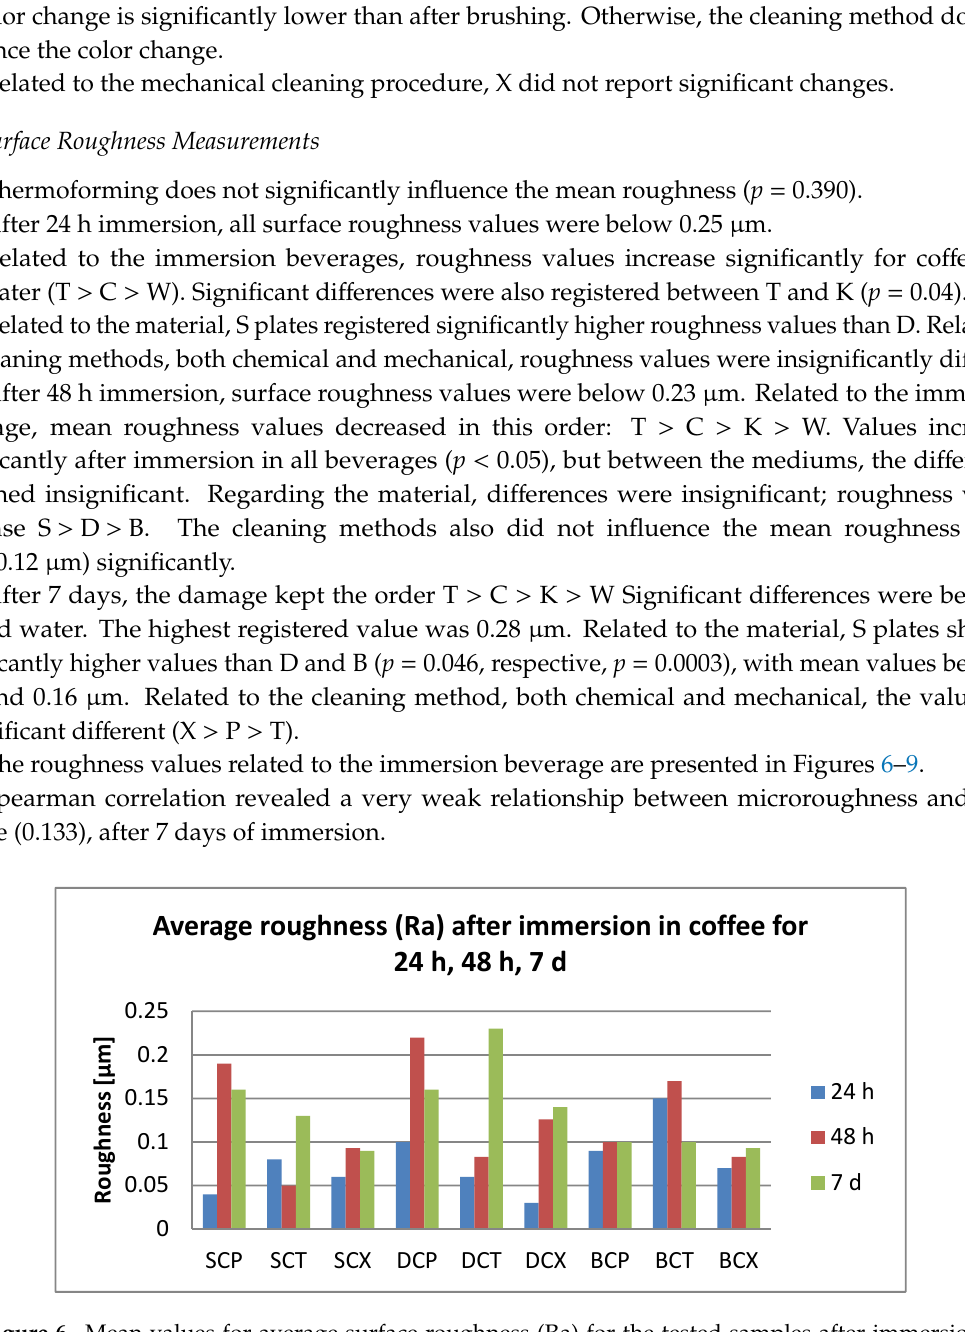
Figure 5. Mean values for ∆ E parameter for all the tested values after immersion in distilled water.